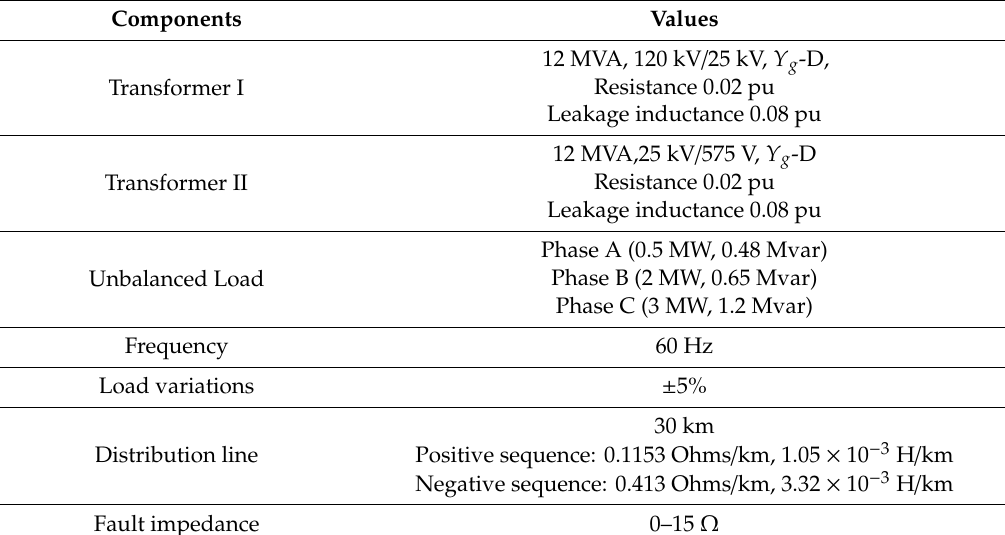
Table 4. Parameters of the distribution network for Scenario